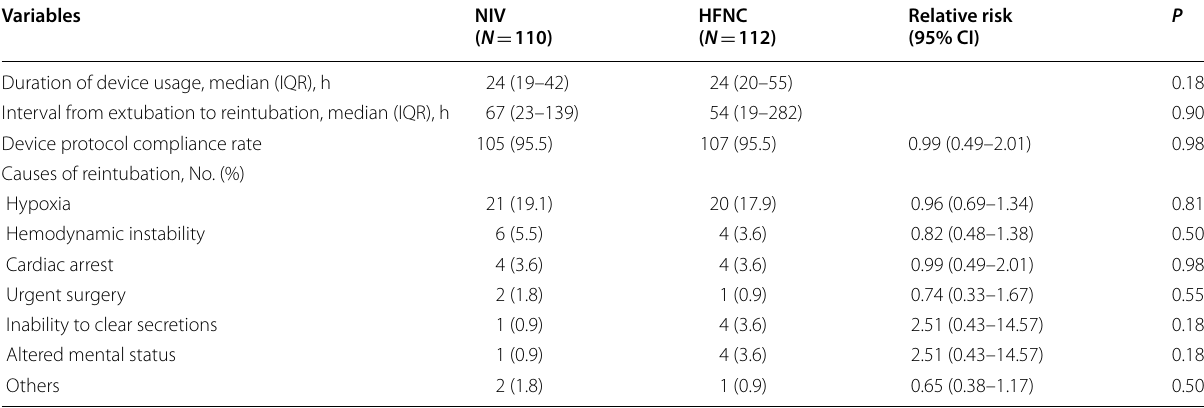
Calculated using patients who required reintubation (37 in the NIV group and 33 in the HFNC group) *Calculated using patients who required a device change (20 in the NIV group and nine in the HFNC group)